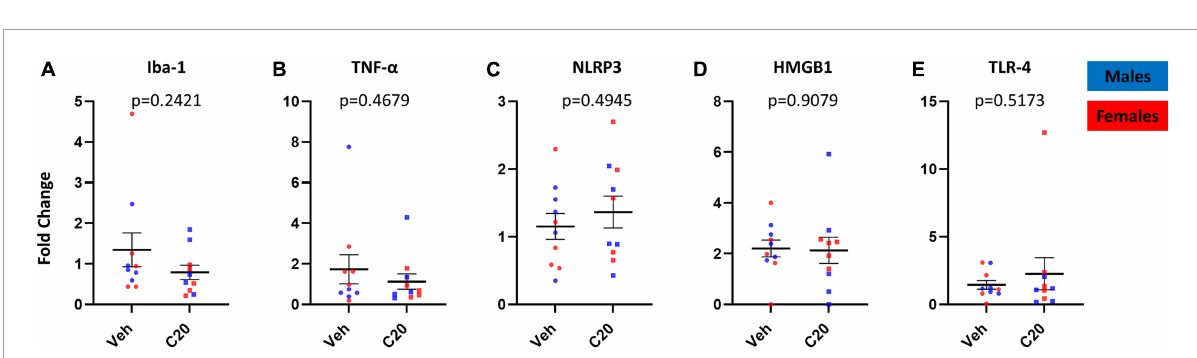
FIGURE4 The mRNA expression of inflammatory mediators in the VH 1 day after the last infusion of C20:0 ceramides. (A–E) Expression of Iba-1, TNF- α , NLRP3, HMGB1, and TLR-4 mRNA in VH tissue after four infusions of C20:0 ceramides into the VH of male and female rats. N = 10 in vehicle group and n = 10 in ceramide infused groups. Males in blue symbols and females in red